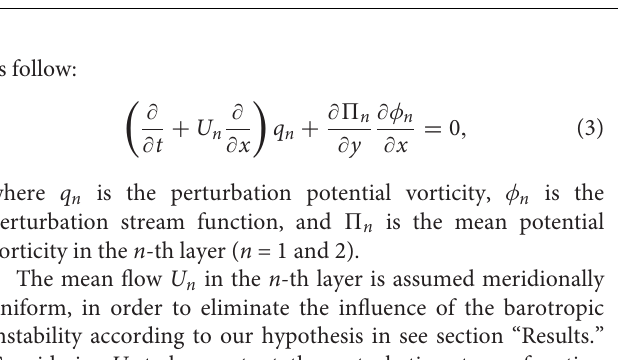
FIGURE 11 | Time-latitude plot of the subsurface zonal velocity (400–600 m) averaged between 128 ◦ and 132 ◦ E during 2010–2016 from OFES outputs smoothed by 1-year moving average.